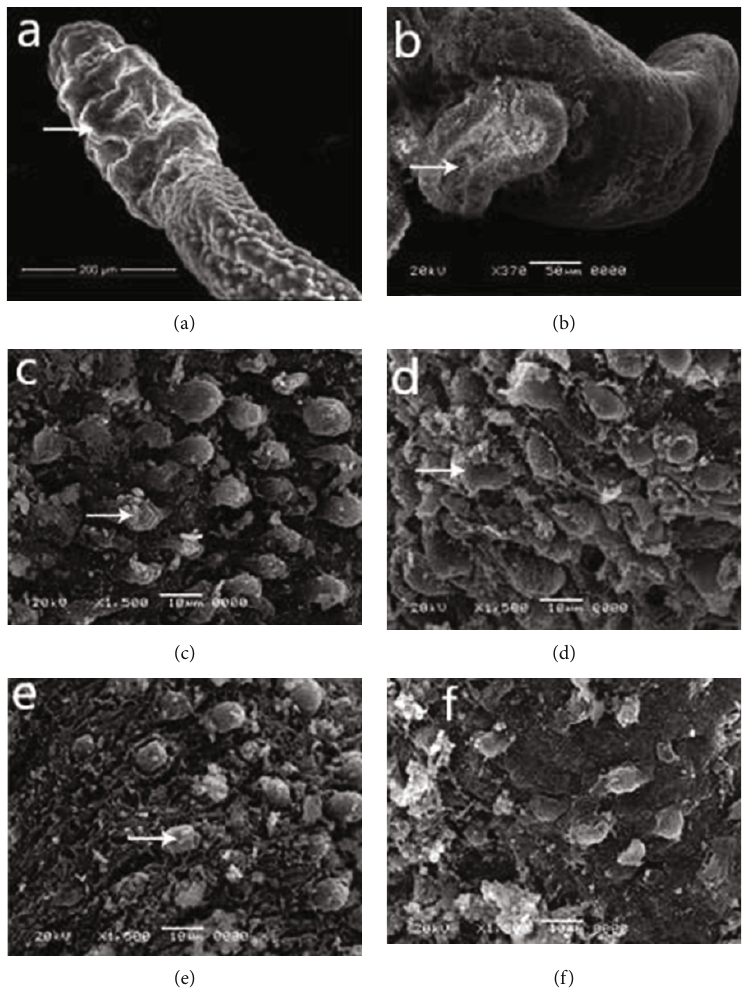
Figure 11: Scanning electron microscopy of S. mansoni (adult worms) after exposure to di ff erent concentration of Coriandrum sativum : (a) destroyed sucker; (b – d) male dorsal surface showing tegumental peeling with damage and peeling of tubercles and